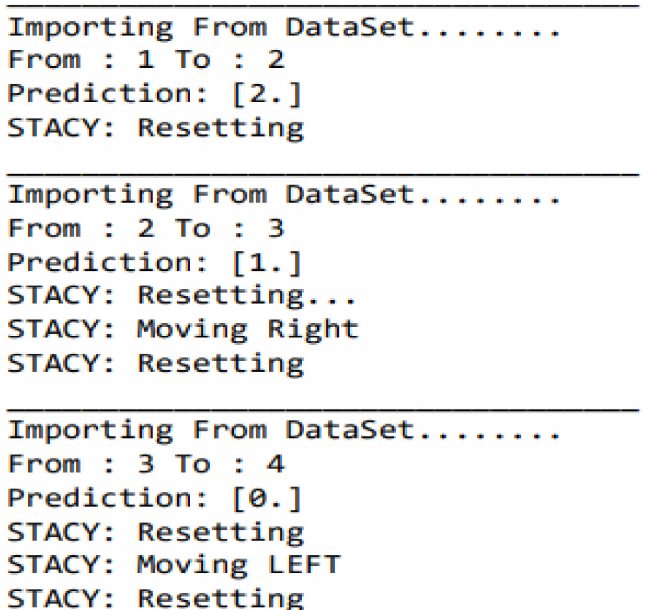
Figure 12. Screenshot of Robotic Arm